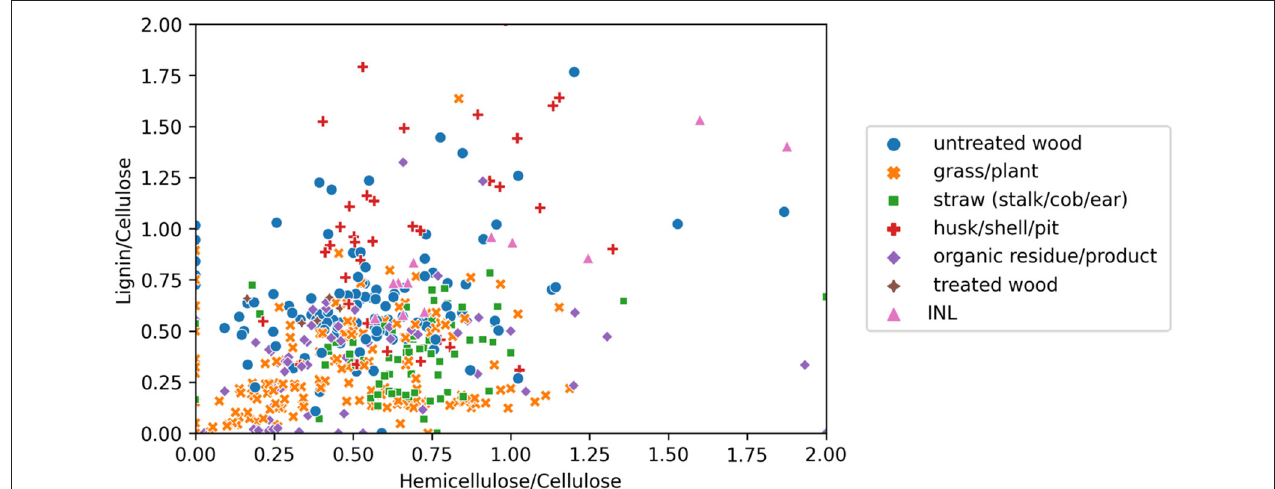
FIGURE 2 | Feedstock lignin/cellulose vs. hemicellulose/cellulose ratios [adapted from INL and Phyllis 2 (ECN, 2012).